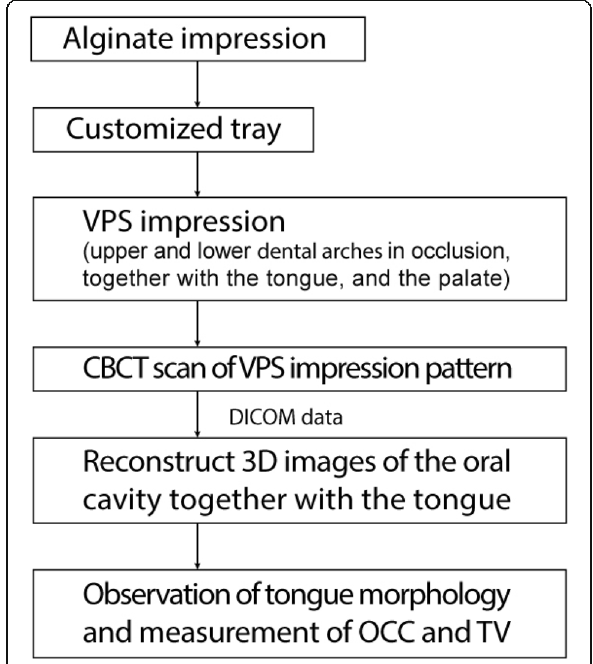
Fig. 1 Methodology flow chart. An alginate impression was taken to make a customized impression tray. The impression of the upper and lower dental arches in occlusion, together with the tongue, and the palate were taken using VPS impression paste. Then, VPS impression pattern was scanned by cone-beam CT, and the DICOM data was obtained. The 3D images of the oral cavity including the tongue were reconstructed from the DICOM data. Observation of tongue morphology and measurements of OCC and TV were